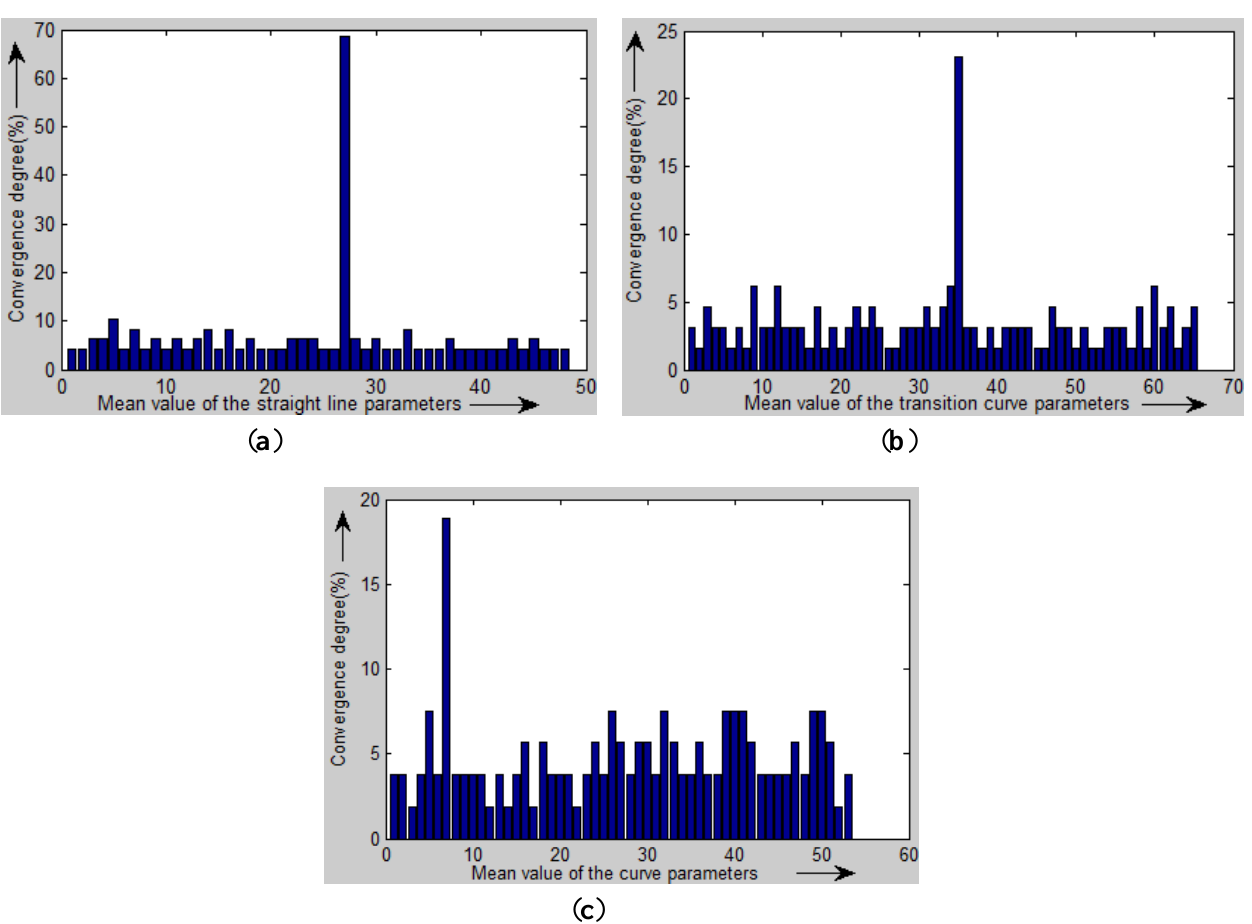
Figure 10. Statistical test results of the optimized BaySAC algorithm. ( a ) Straight line; ( b ) Transition curve; ( c )